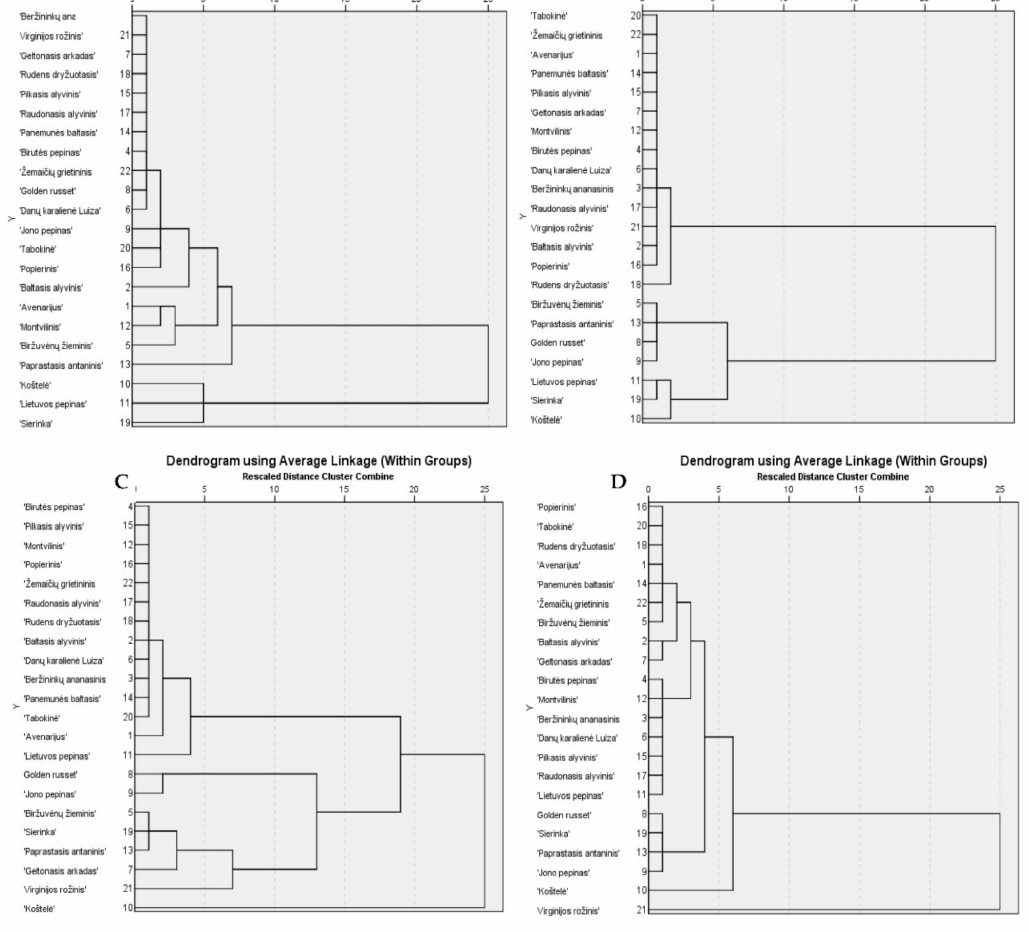
Figure 6. Dendrogram of the similarity of apple samples in terms of the amounts of phenolic compounds. Flavonols were distributed into three clusters ( A ), chlorogenic acid was distributed into four clusters ( B ), ( − )-epicatechin, ( + )-catechin, and phloridzin were distributed into four clusters ( C ), and compounds of the procyanidin group were distributed into four clusters ( D